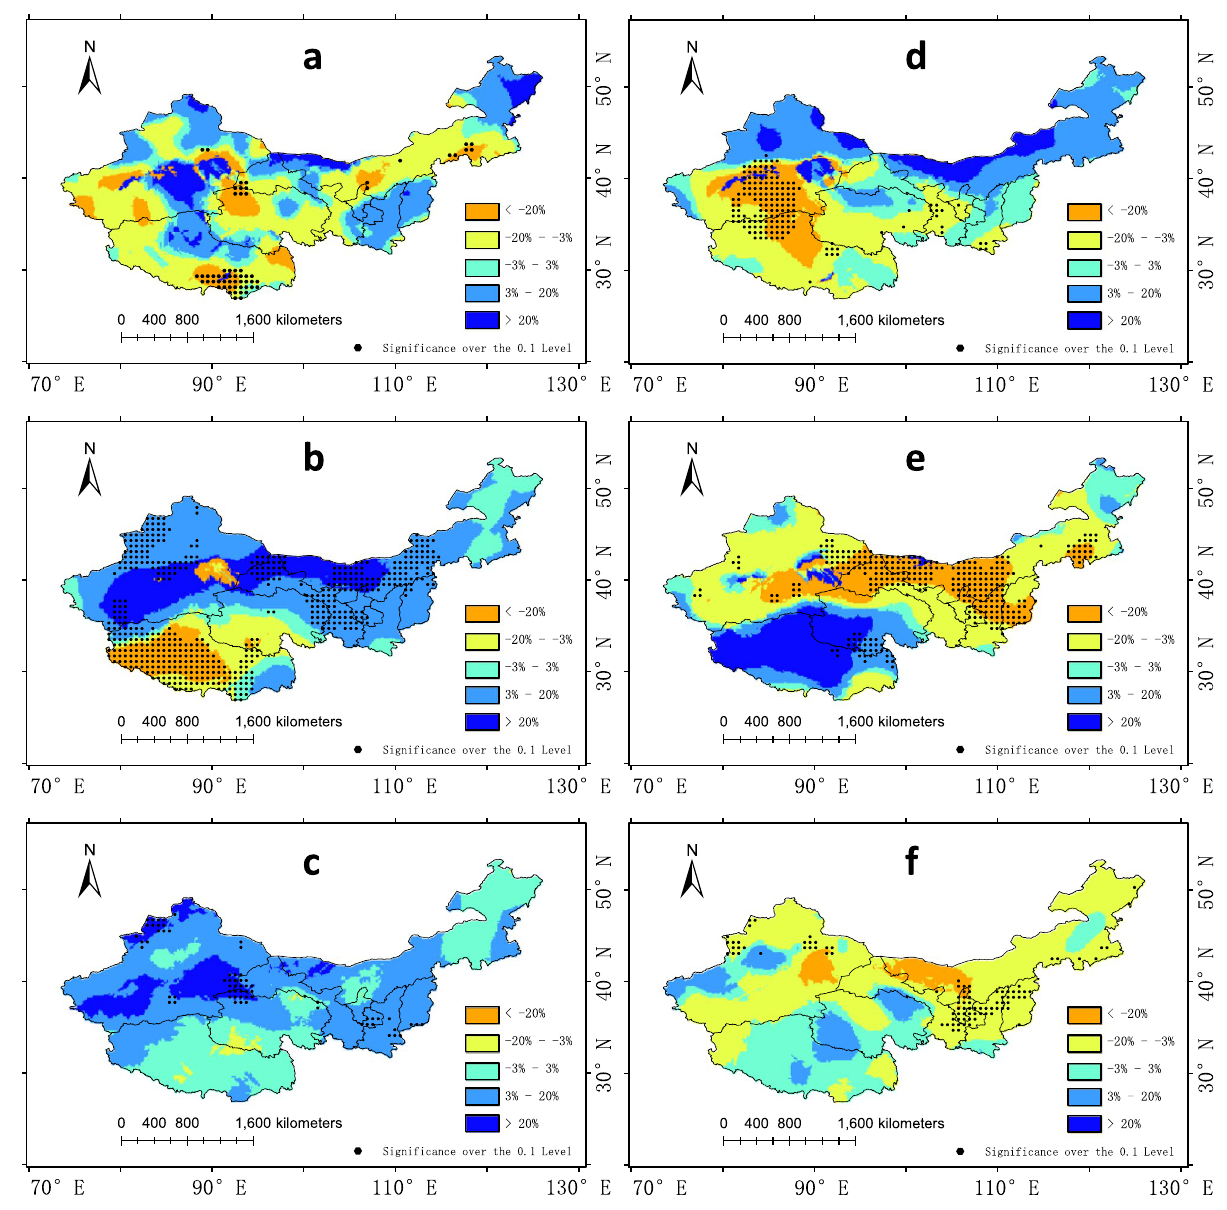
Figure 10. The composite seasonal precipitation anomaly percentage for D(0)JF(1), MAM(1), and JJA(1) seasons. Figures ( a – c ) represent El Niño years and Figures ( d – f ) represent La Niña years. The dotting represents the 0.1 significance level. The maps are generated with Arc Map version 10.5 (http:// www. esri. com/ sofwa re/